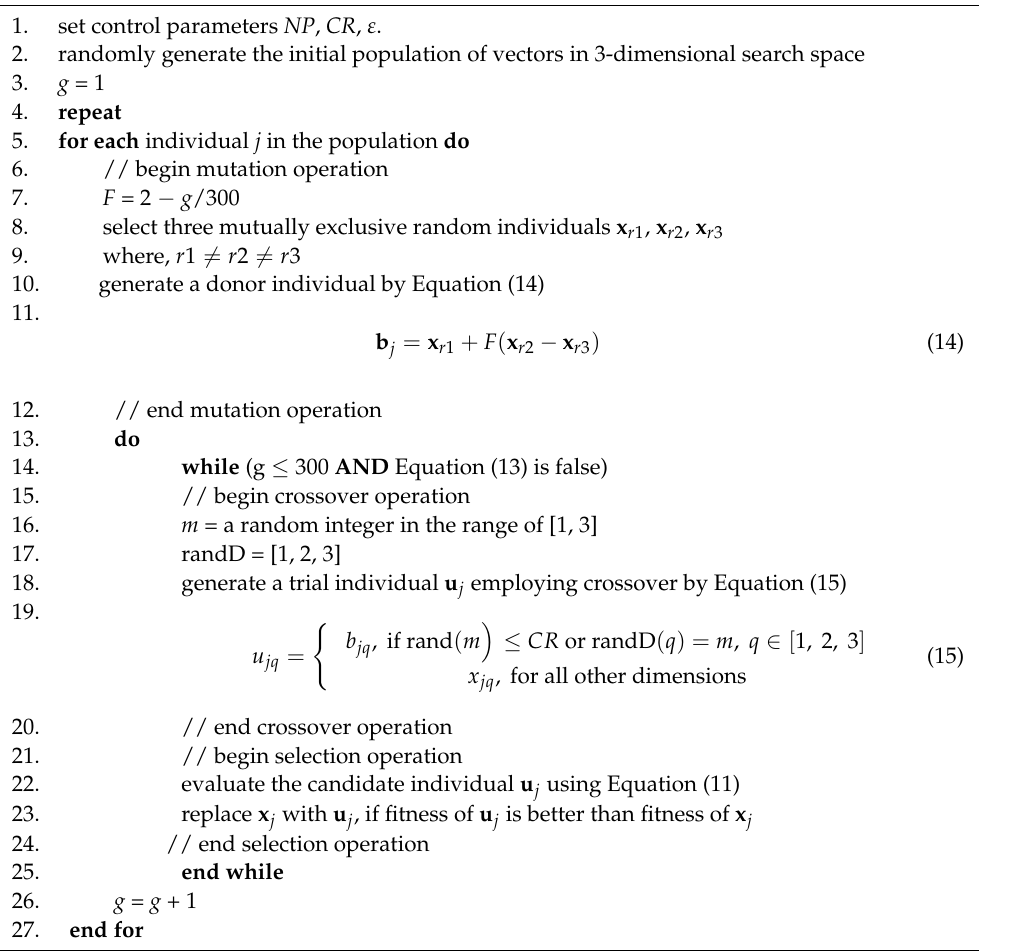
Algorithm 1 Pseudo-Code for the DE